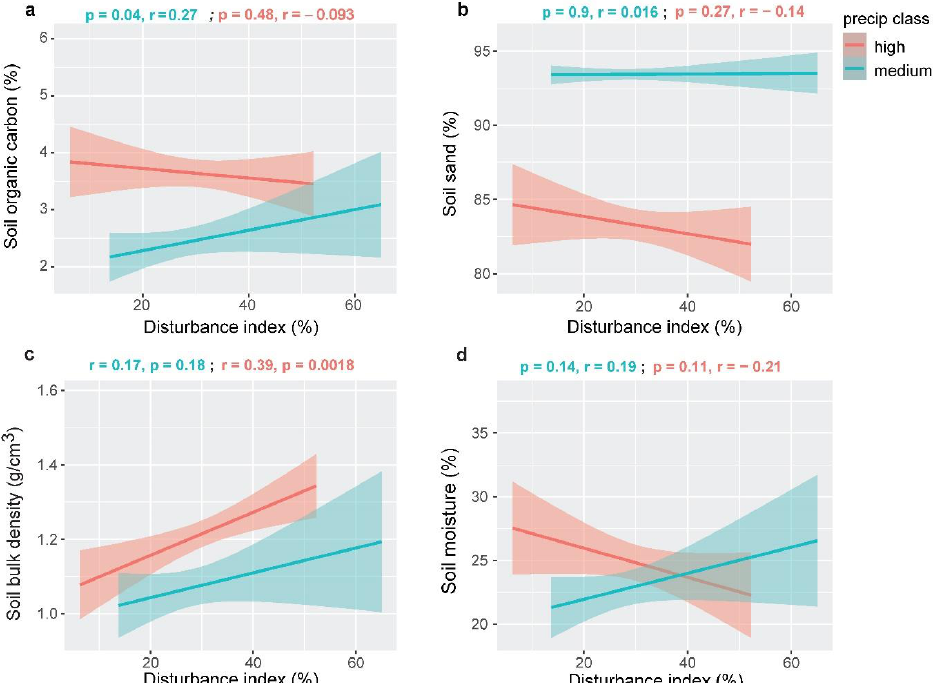
Figure 3. Relationships between disturbance and belowground ecosystem services under high- and medium-rainfall regimes in our study sites in Northeast Bangladesh.